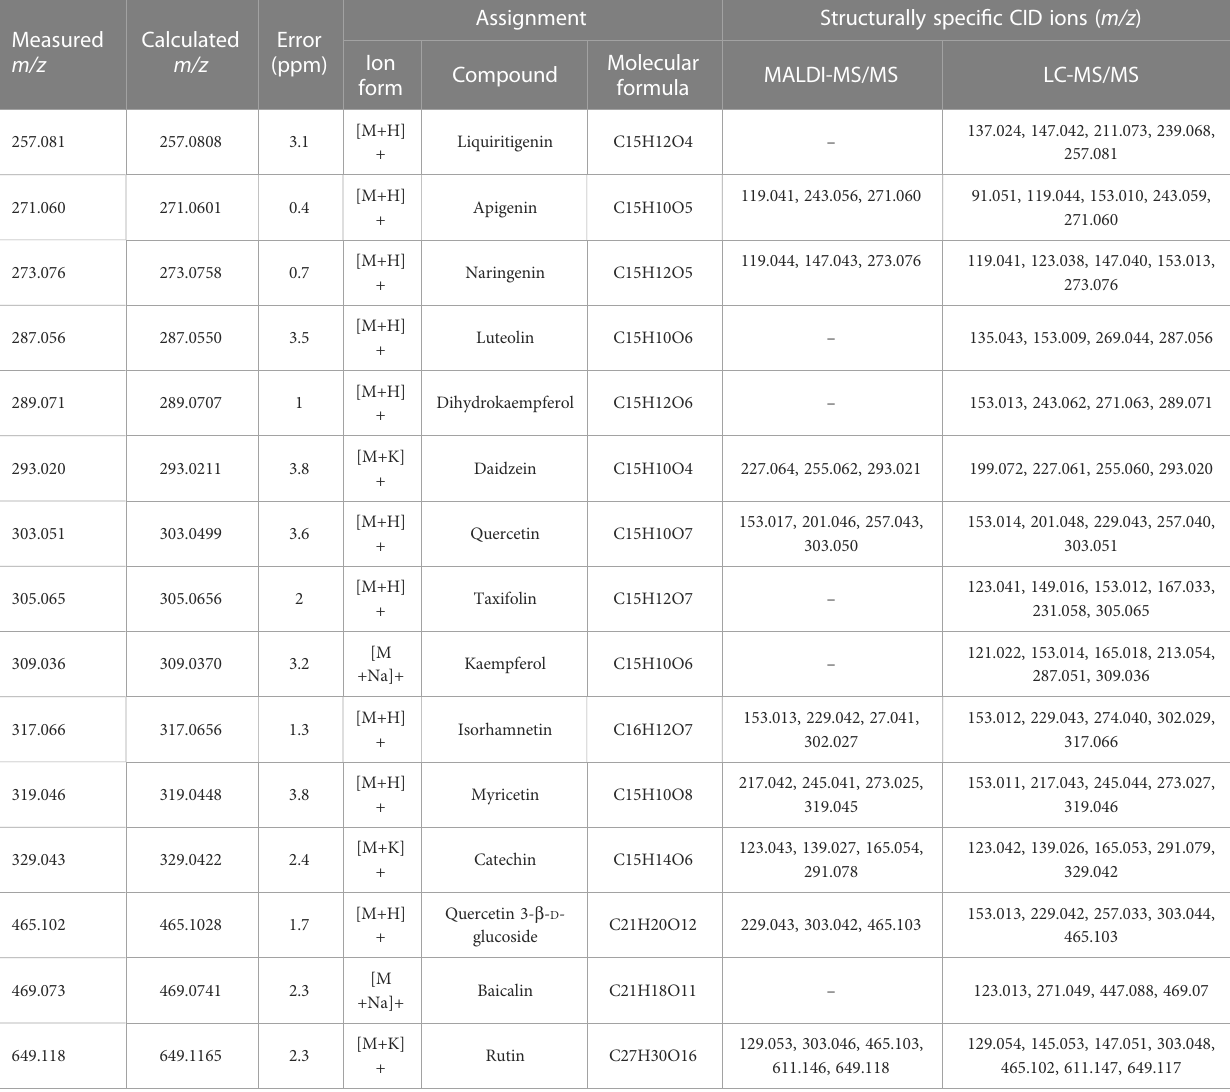
TABLE 1 The lists of 15 detectable fl avonoids in litchi seed tissue sections by MALDI-TOF-MS using 2-MBT as the matrix in the positive ion mode.